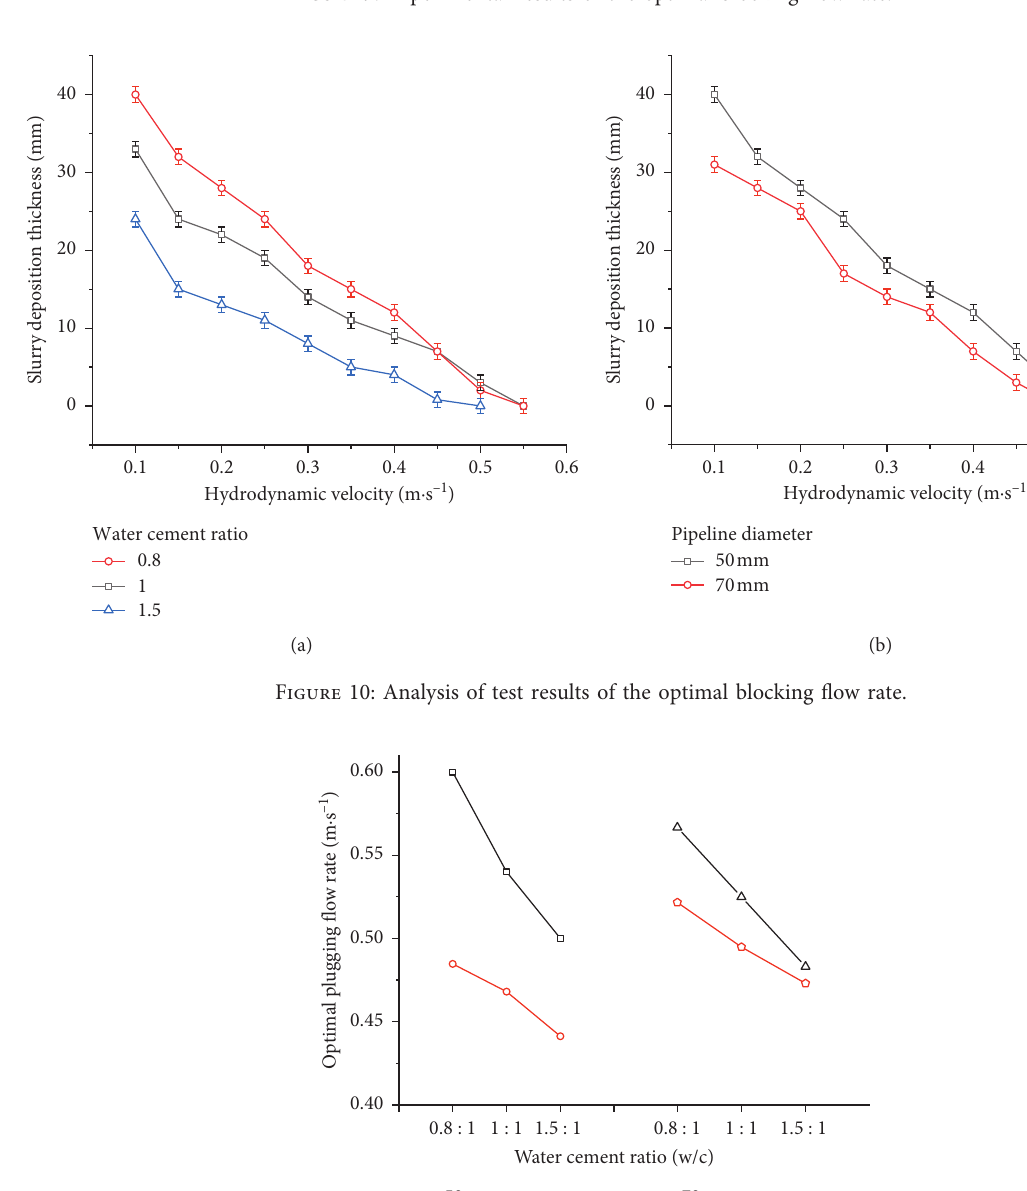
Figure 9: Experimental results of the optimal blocking flow rate.